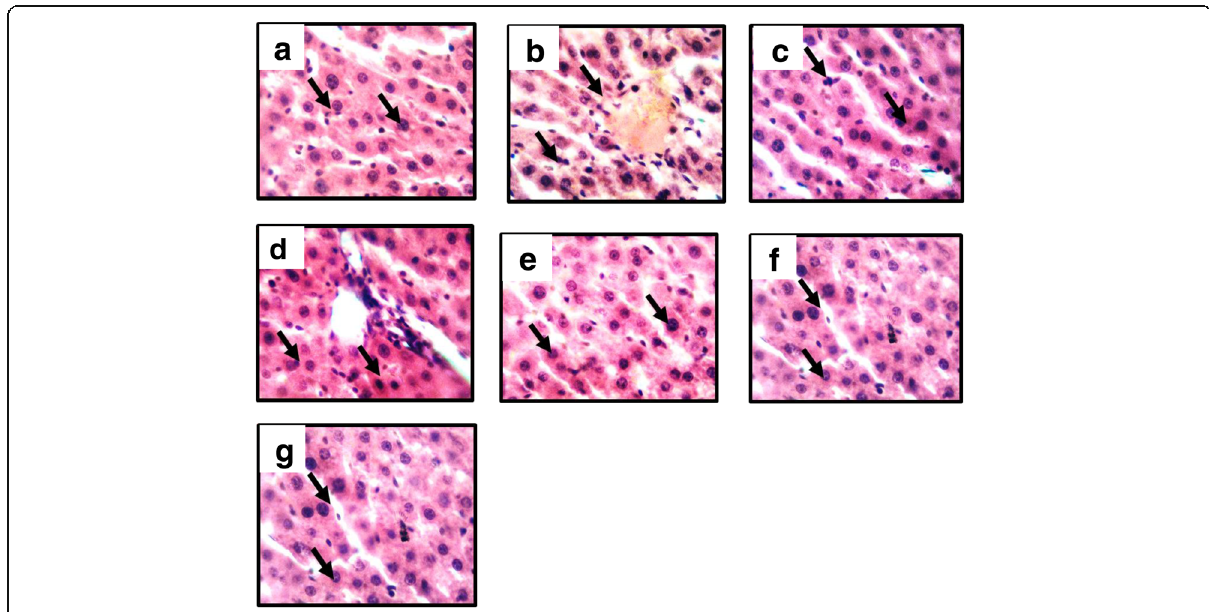
Fig. 1 Representative photomicrograph (× 400, Haematoxylin and eosin stained) of the liver of ( a ) control, ( b ) model group; ( c ) Extract treated; ( d ) Glucophage treated; ( e ) Extract + lisinopril treated ( f ) Glucophage + lisinopril treated; ( g ) Lisinopril treated rats